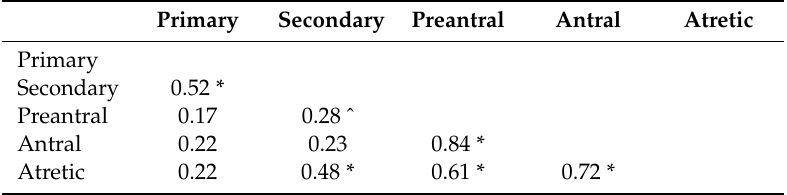
Table 5. Pearson’s correlation coe ffi cients between ovarian follicle populations at 160 days of age.